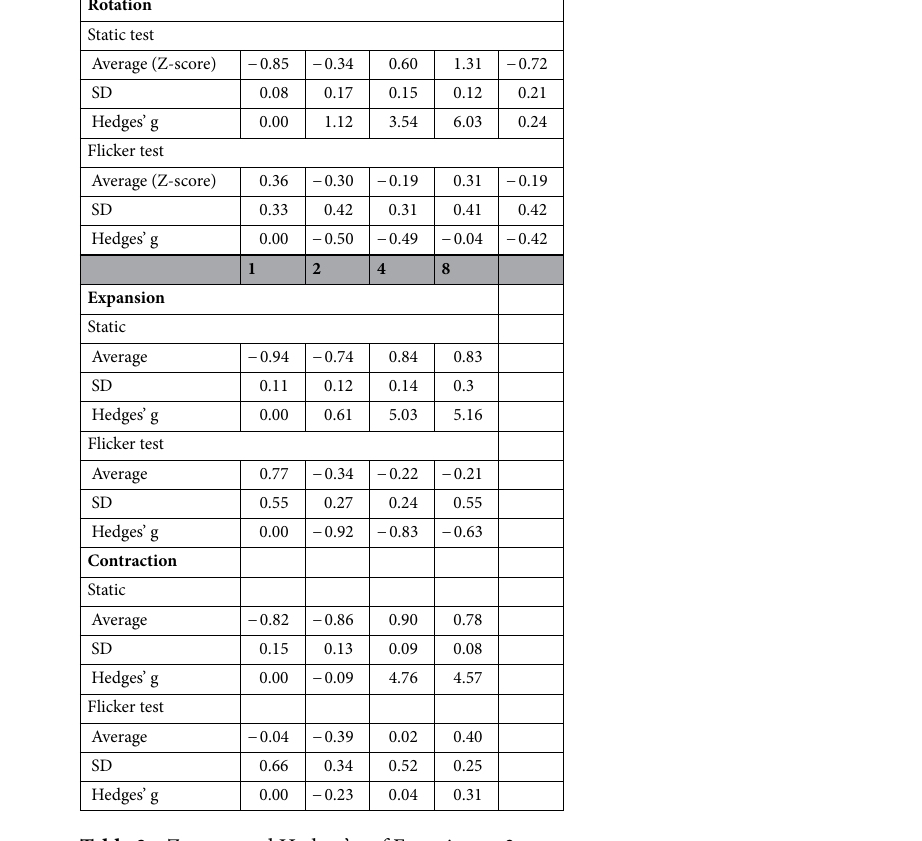
Table 2. Z-score and Hedges’ g of Experiment